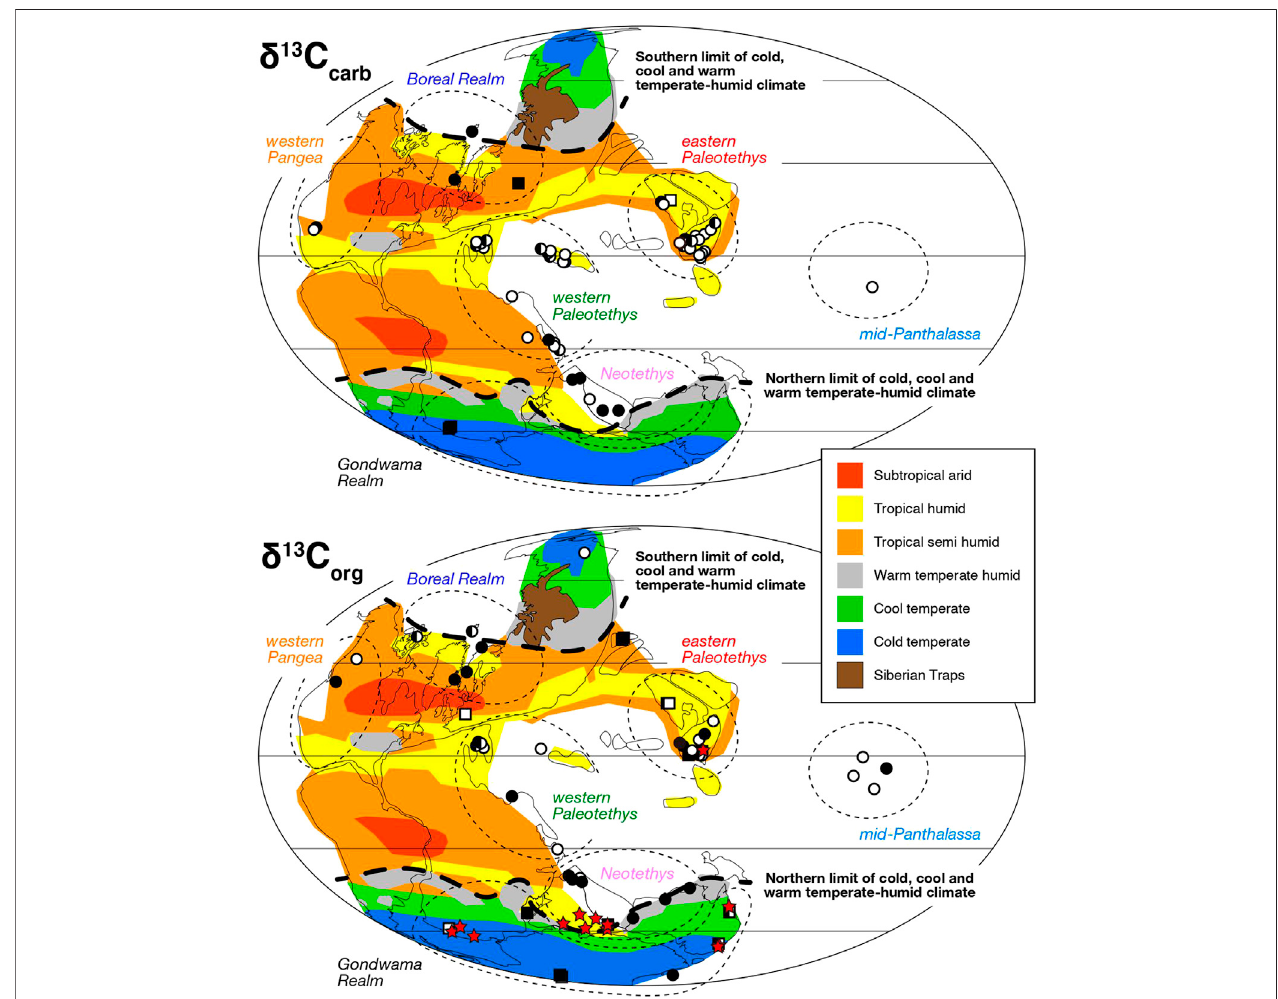
FIGURE 6 | Paleolocation map of the P-TB sections examined in inorganic (upper) and organic (lower) carbon isotope studies. Marine and terrestrial sections are shownascirclesandsquares,respectively.FilledandopenedsymbolsrepresentsectionsinwhichthereportedmagnitudeoftheP-TB δ 13 C carb decreaseislarge( > 5 ‰ ) and small ( < 5 ‰ ), respectively. A half- fi lled symbol represents a section in which both large and small δ 13 C decreases were reported. A terrestrial section at which the P-TB δ 13 C org decrease is not clearly recognized is shown as a red star. The paleolocation of mid-Panthalassan sections is not precisely speci fi ed. Paleoclimate classi fi cation is after Schneebeli-Hermann (2012) and Benton and Newell (2014).